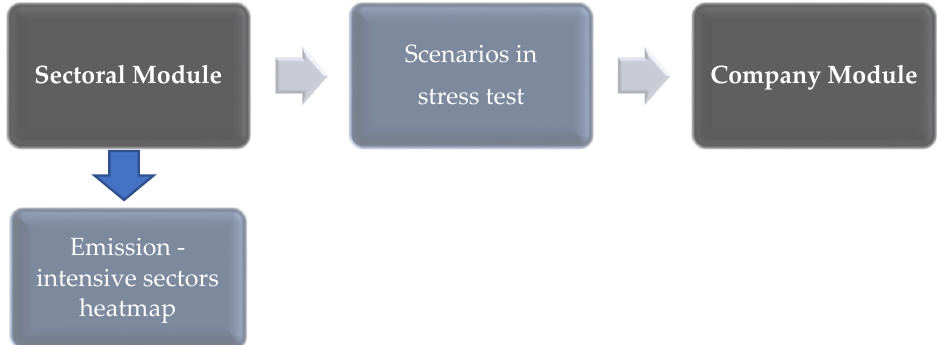
Figure 9. Workflow by which to determine the banking sector’s ability to deal with the possible implications of climate-related risk.